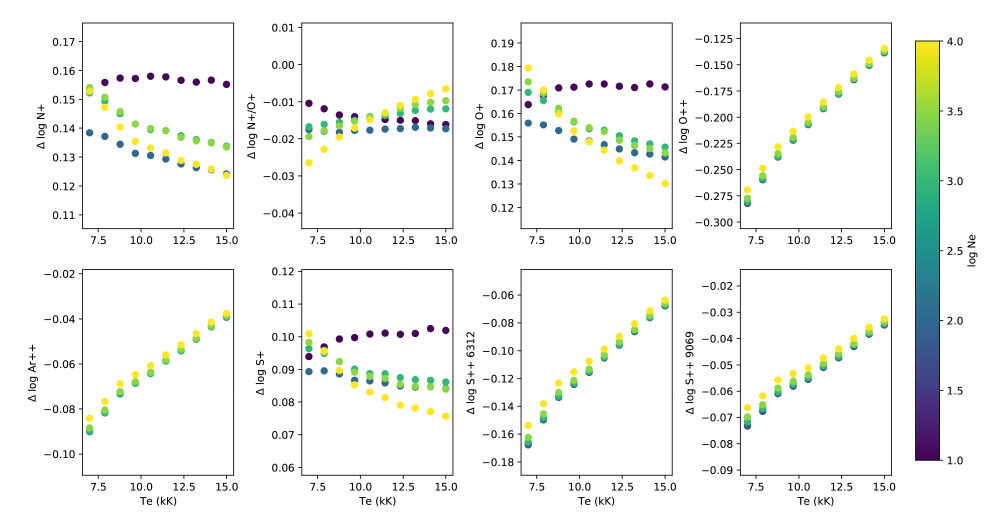
Figure 9. Abundance logarithmic differences for several ions caused by using the MBZ20 ECS relative to the PyNeb defaults.